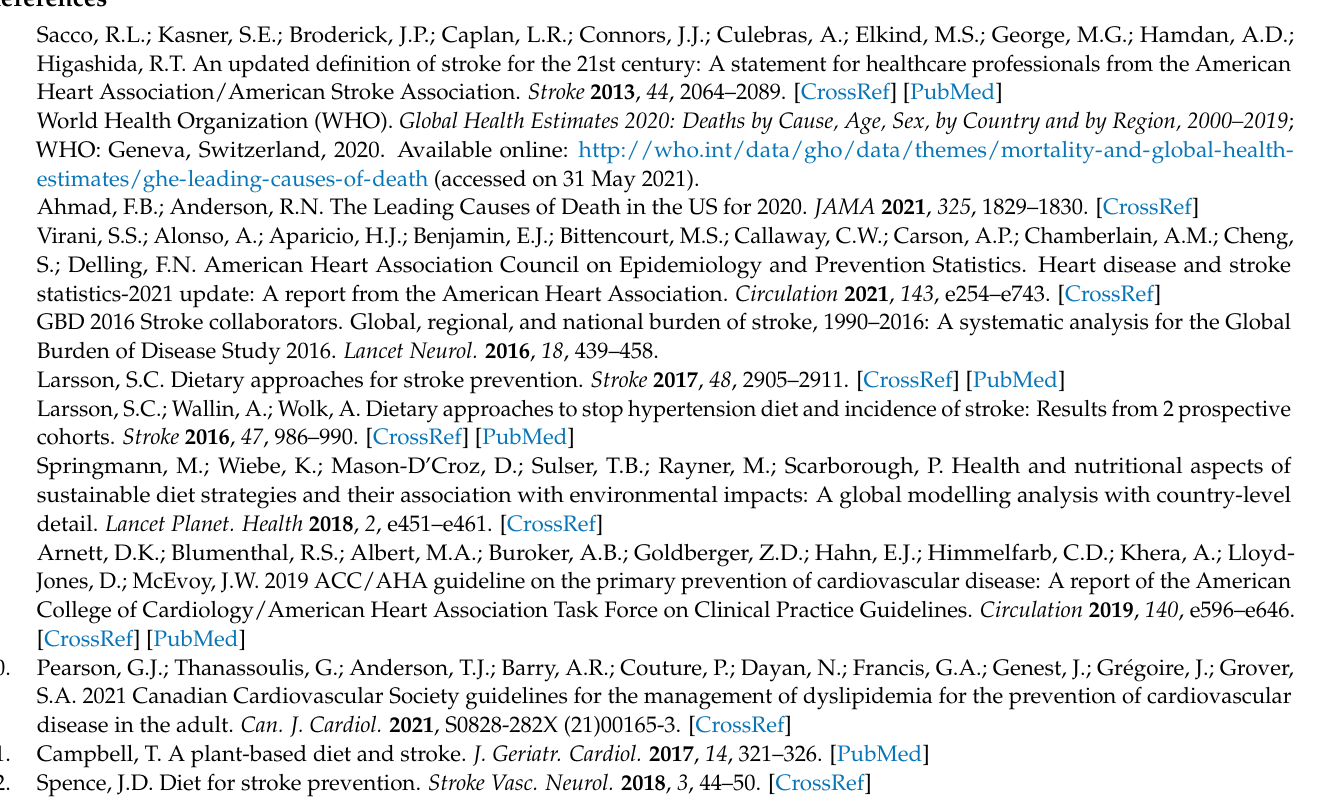
databases. Figure S1. PRISMA flowchart of the selection process. Figure S2. Leave-one-out sensitivity analysis. Figure S3. Funnel plot for total stroke. Table S1. List of excluded studies during the selection process. Table S2. Adjusted covariates of individual studies. Table S3. Risk of bias assessment of the included studies using the Newcastle–Ottawa